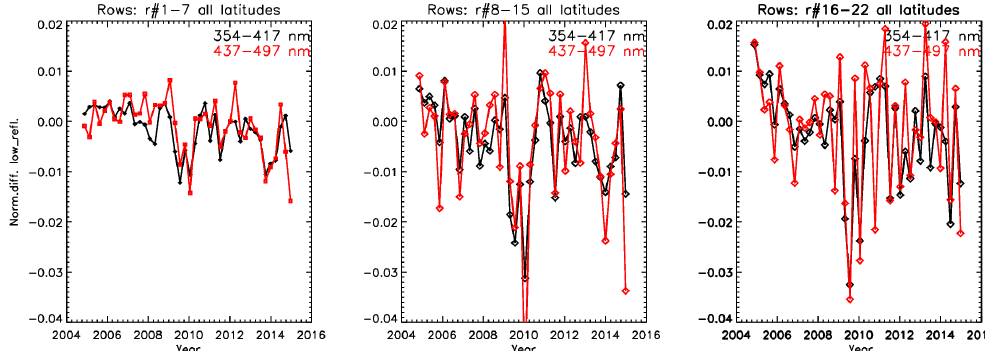
Figure 24. The time-, row- and wavelength-binned, normalized and seasonally de-trended VIS radiances sampled at all latitudes over the low-reflectance ( r <10%) terrain. All shown rows are presumably not affected by the row anomaly; though notice the changes around 2009–2010.